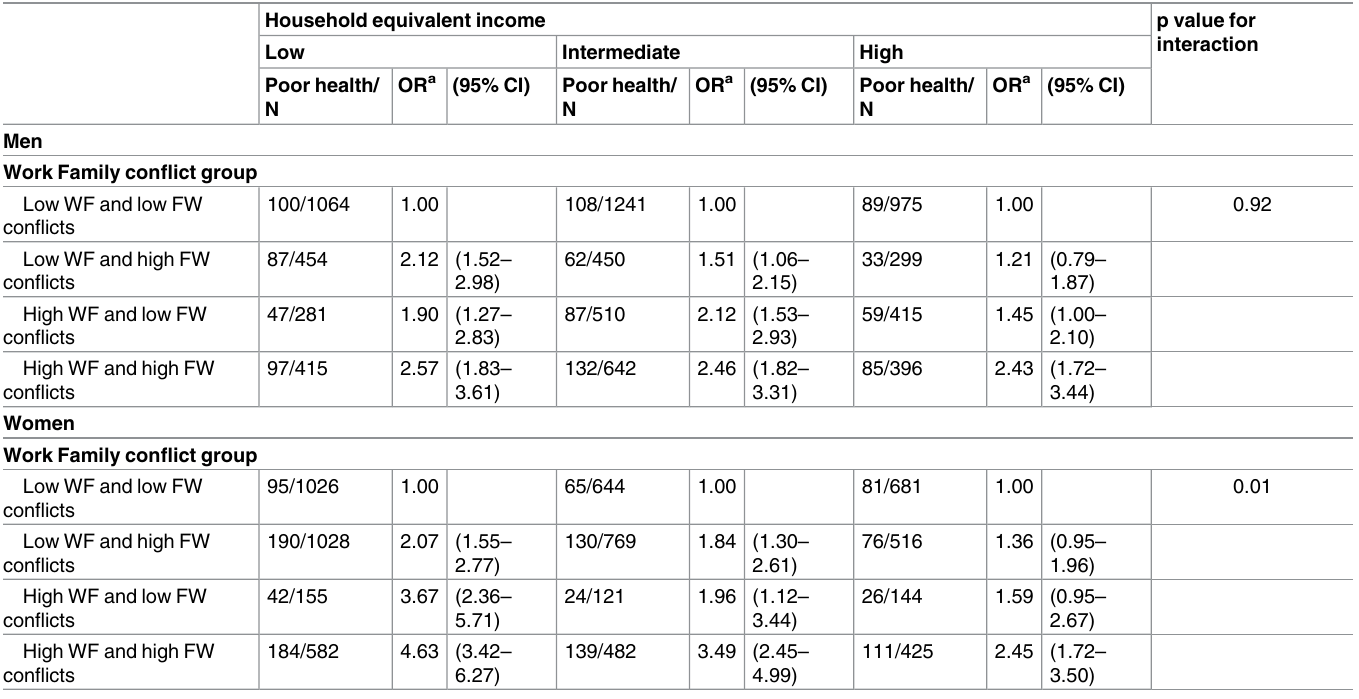
Table 3. Odds ratios (OR) for poor self-rated health associated with work–family conflict, by household equivalent